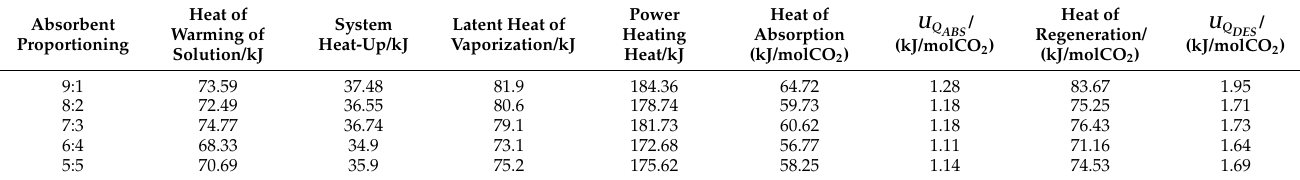
Table 10. Reaction heat test of AEP-DPA system with different proportion.